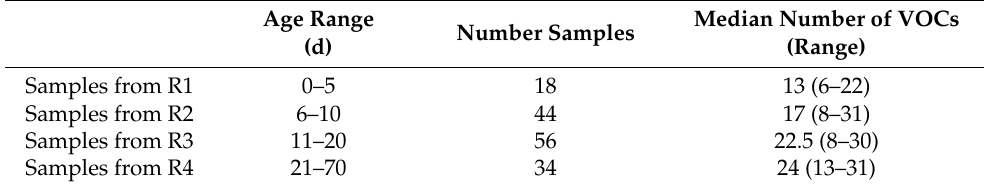
Table 3. Samples collected in each age group.